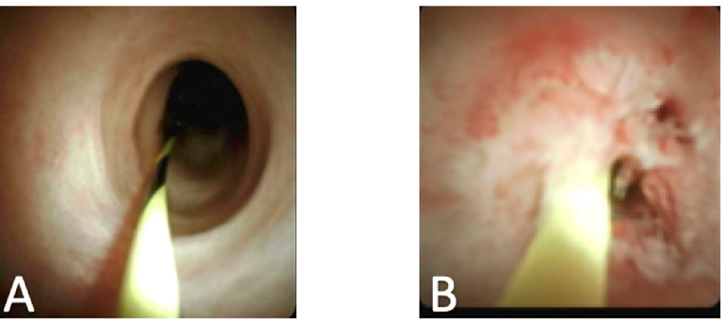
Figure 5. ( A ) Bile duct guidewire; ( B ) Passage of guidewire through stenosed bile duct.